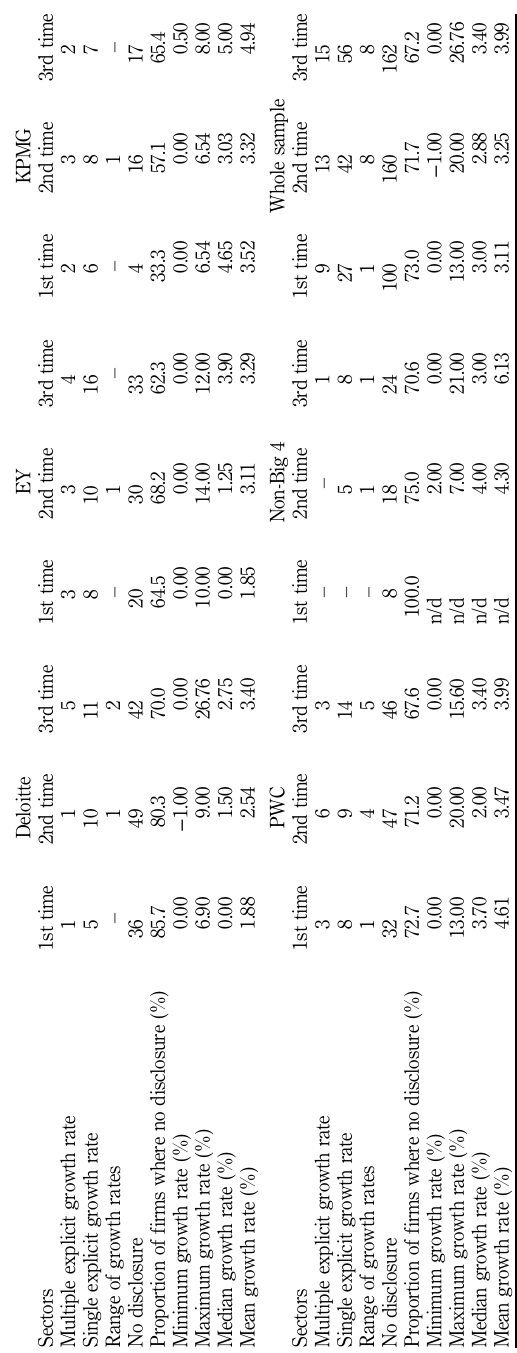
Table VI. Analysis of growth rates used to test impairment (value in use and mixed method used